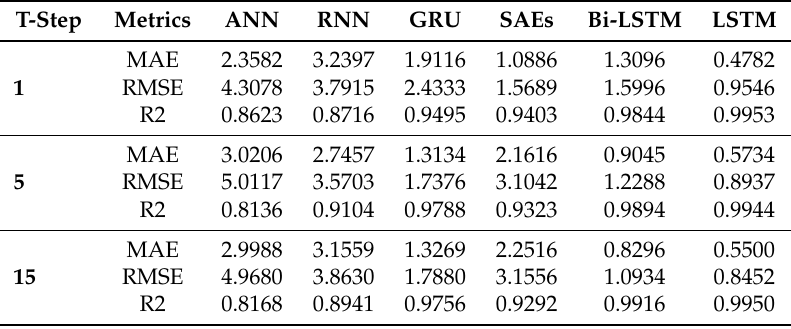
Table 2. Performance comparison of the MAE, RMSE, and R2 for all methods.